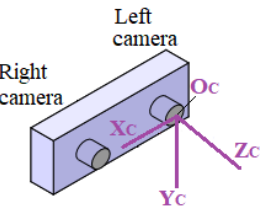
Figure 7. Position and orientation of the camera